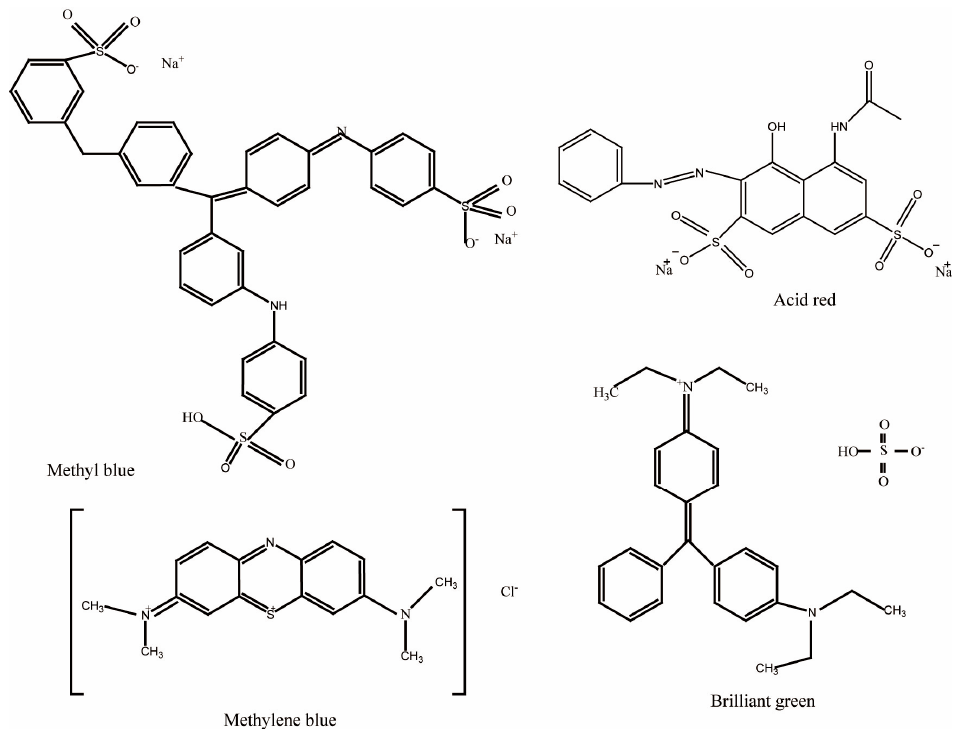
Figure 1. Molecular structure of dyes.